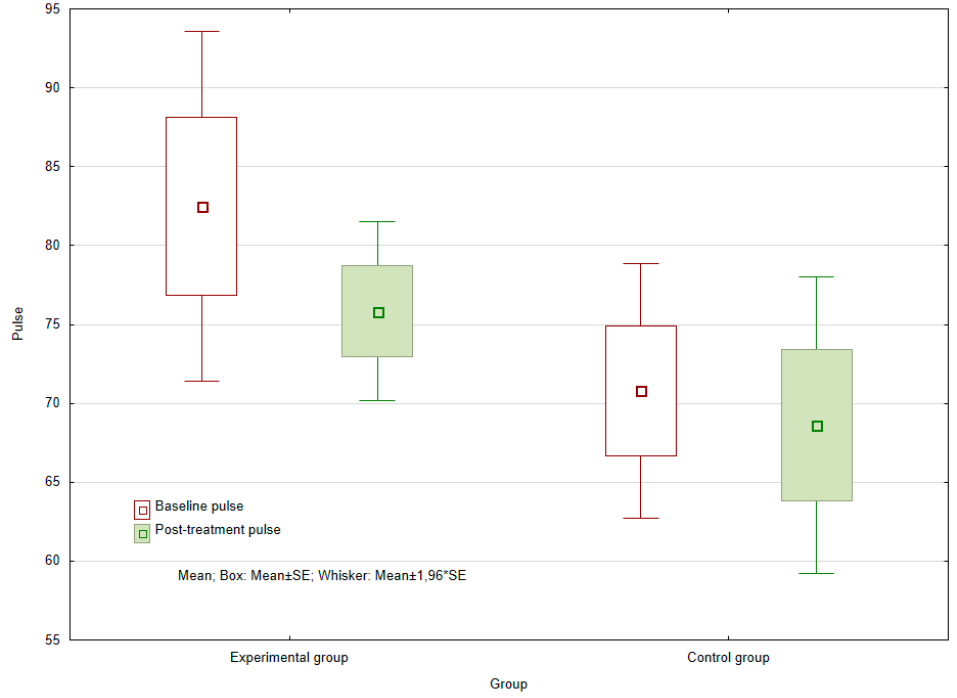
Figure 1. Baseline and post-treatment heart rate of the experimental and control groups. Int. J. Environ. Res. Public Health 2019 , 16 , x